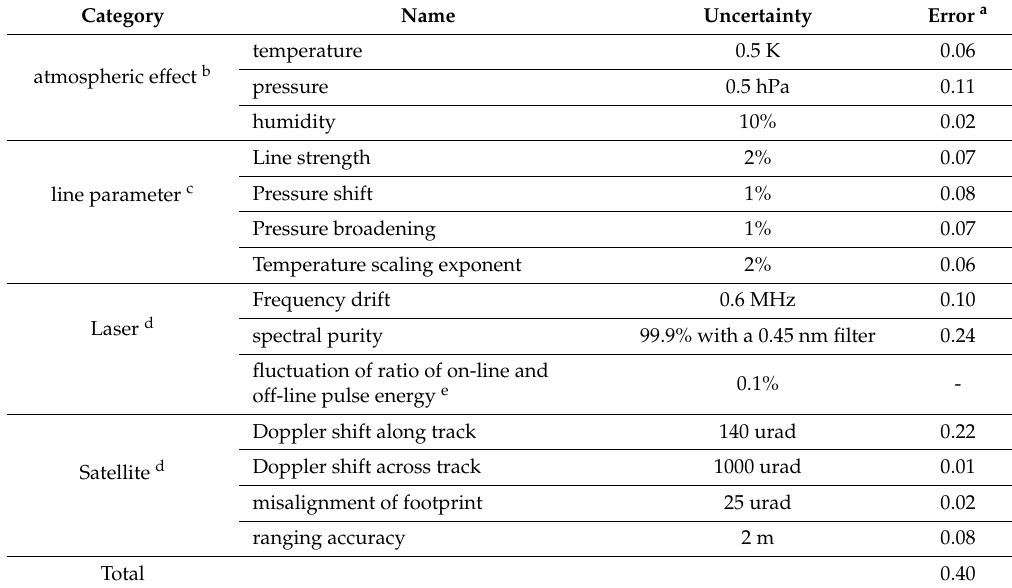
path differential absorption lidar). Table 1. Calculated systematic errors according to the configuration of the CO 2 -IPDA (integrated